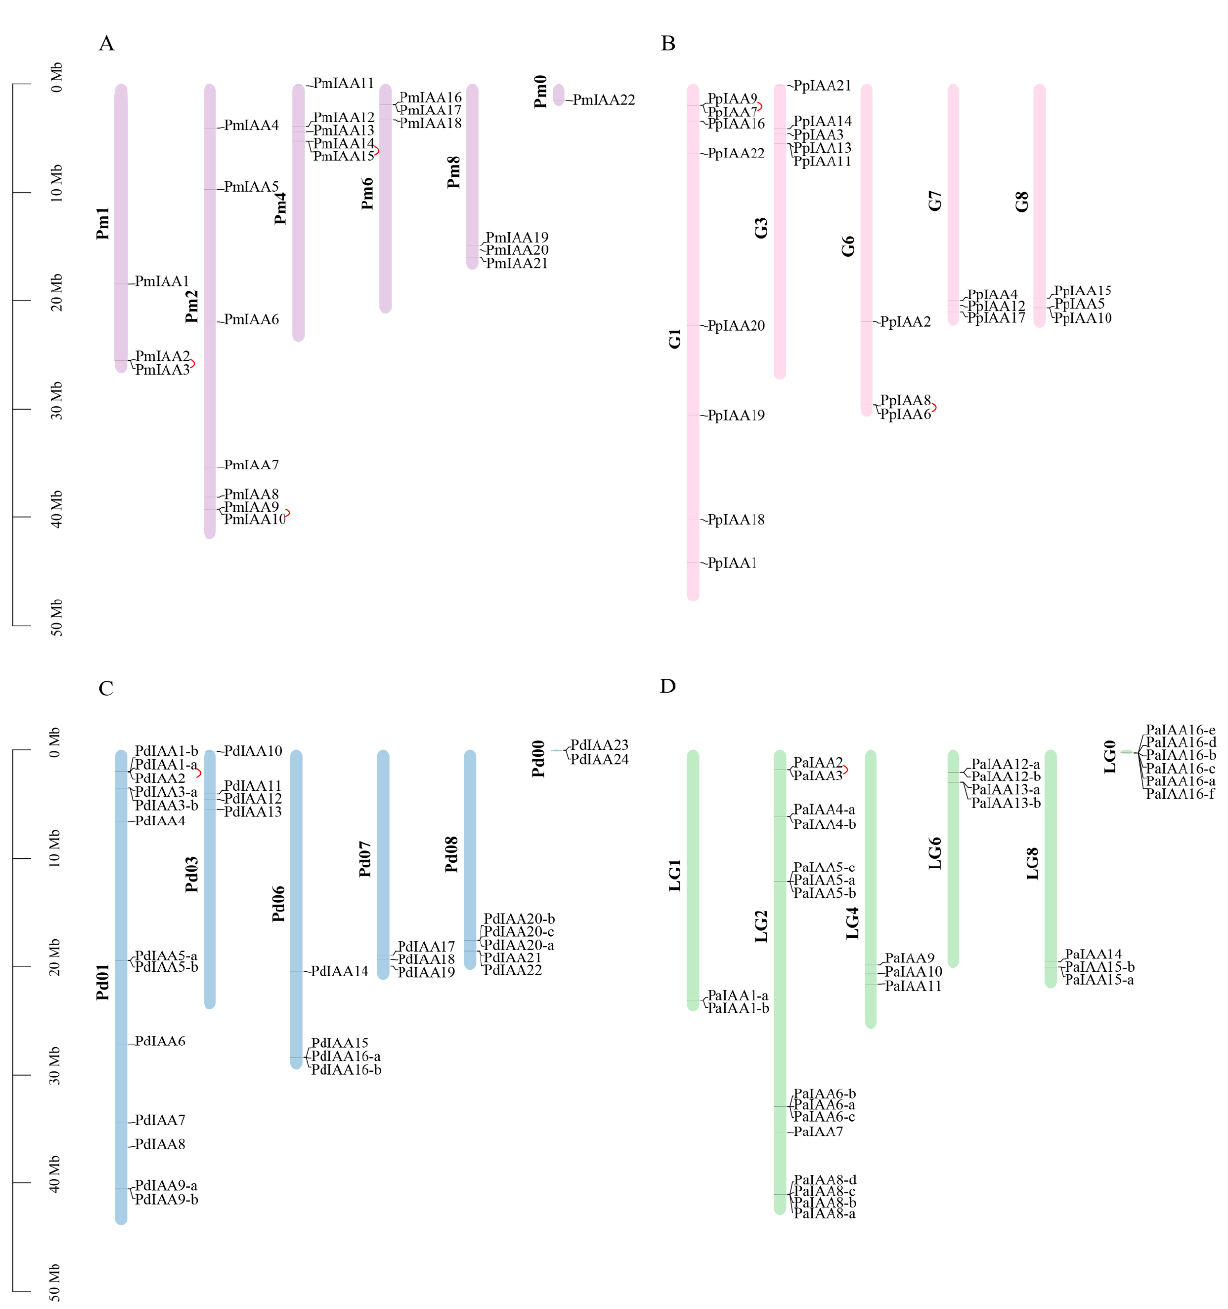
Figure 3. Chromosomal location of RoIAA genes. ( A – D ) Chromosomal distribution of PmIAAs (purple), PpIAA s (pink), PdIAA s (blue), and PaIAA s (green), respectively. Pm, G, Pd, and LG represent the number of chromosomes in P. mume , P. persica , P. dulcis , and P. armeniaca , respectively. Pm0, Pd00, and LG0 represent unassigned chromosomes. Pm0 is scaffold205 in the genome of P. mume . Pd00 is pdulcis26_s0670 in the genome of P. dulcis . LG0 is tig00008361 in the genome of P. armeniaca . Red line represents tandem duplication of RoIAAs . Length of chromosomes could be inferred by the left scale.